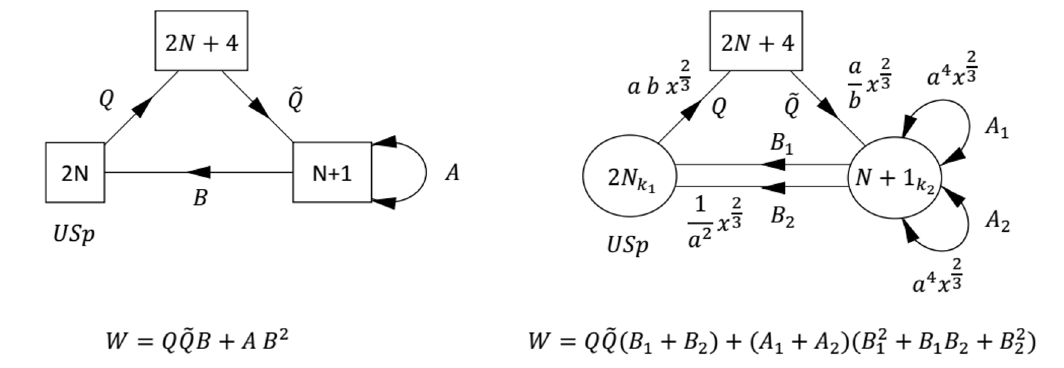
Figure 4 . On the left the 3 d quiver theory associated with the compactification of the 5 d SCFT with SU(2) × SO(4 N +8) global symmetry on a tube with some flux in its global symmetry. Similarly, on the right we have the case associated with compactification on a torus. The fields A , A 1 and A 2 stand for antisymmetric chiral fields, where we use the notation of arcs with two ingoing or outgoing arrows for antisymmetric or complex conjugate antisymmetric chiral fields. This should not lead to any confusion with possible symmetric representations as in all of our paper we only have antisymmetric representations and never symmetric ones. The subscript in the gauge nodes denotes the CS levels. Here we have momentarily allowed for a general CS term, though the case with the 5 d origin has k 1 = k 2 = 0 . The charges of the fields under the two U(1) global symmetries are displayed using the fugacities a and b , with the fugacity x displaying the charges under a chosen U(1)